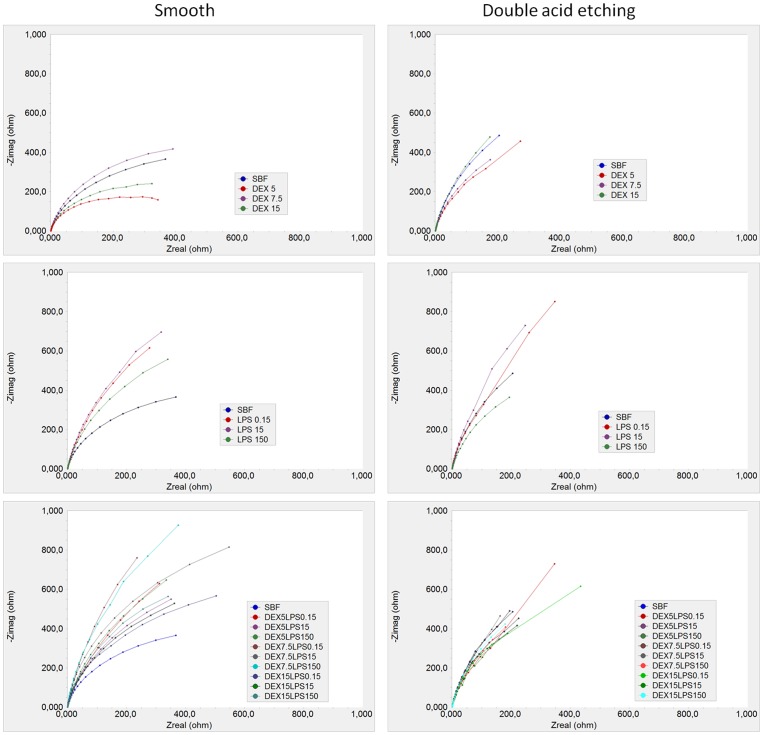
Electrochemical impedance spectroscopy (EIS) represented by the Nyquist plot of the Ti-6Al-4V alloy.Tests were conducted in simulated body fluid - SBF (control) with different concentrations of dextrose (DEX), lipopolysaccharide (LPS), and combinations of dextrose and lipopolysaccharide (DEXLPS).